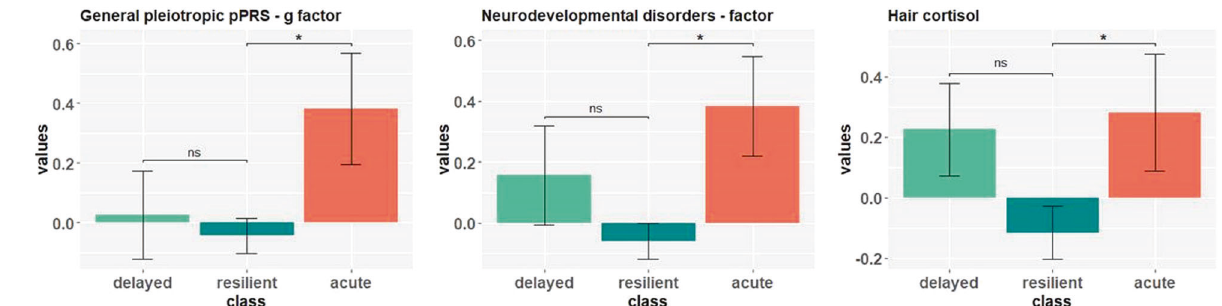
Fig. 3 Class comparisons regarding signi fi cant environmental and genetic factors. Signi fi cance based on bivariate logistic regressions (reference class = “ resilient ” ). Data is z-transformed. Error bars = + / − 1 standard error (SE). “ Delayed ” = “ delayed dysfunction ” class; “ acute ” = “ acute dysfunction ”